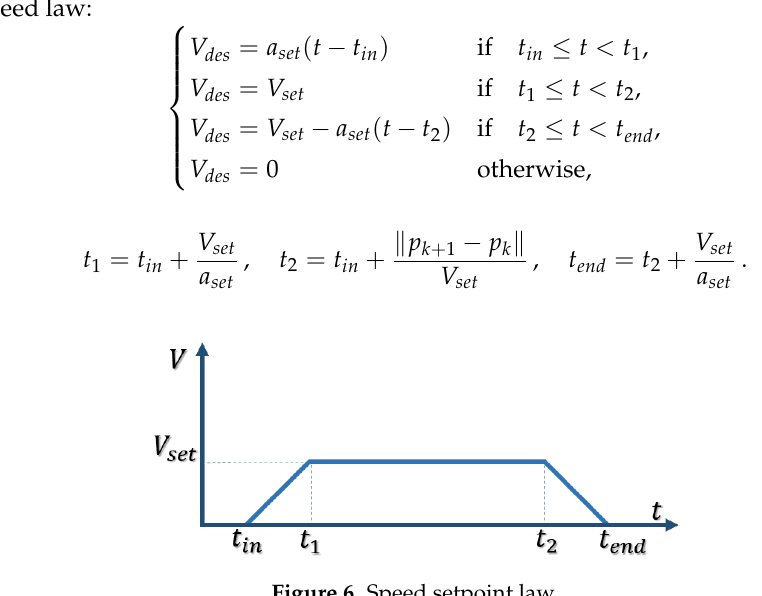
Figure 6. Speed setpoint